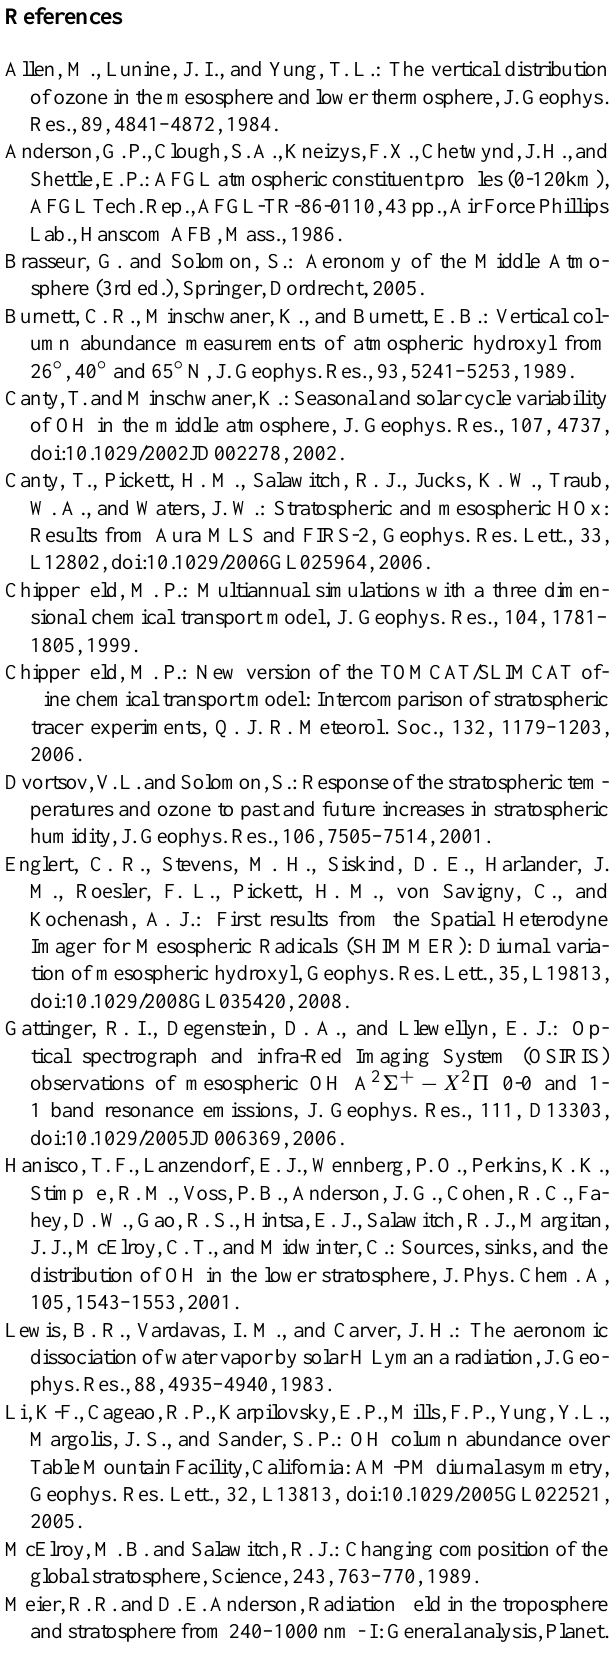
Table Mountain Facility, California: AM-PM diurnal